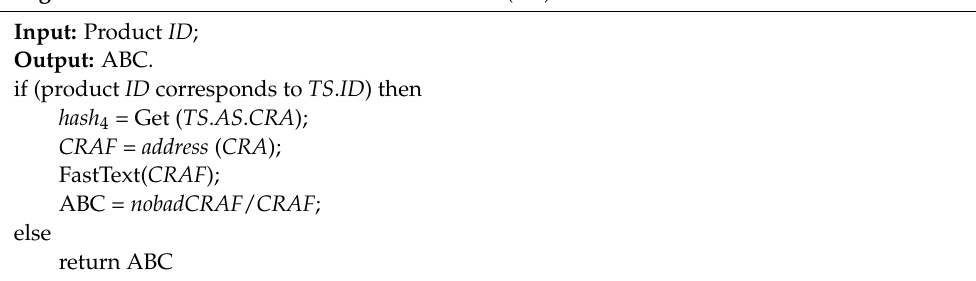
Algorithm 2: Consumer Authentication Contract